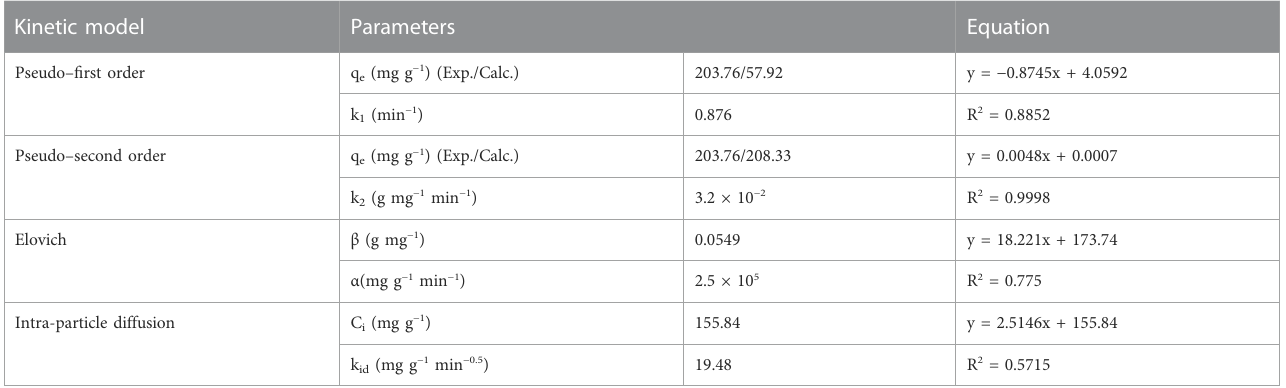
TABLE 1 Kinetic parameters of the sorption of acid red 37 dye by CM- β CD:nChi:Glu. Kinetic model